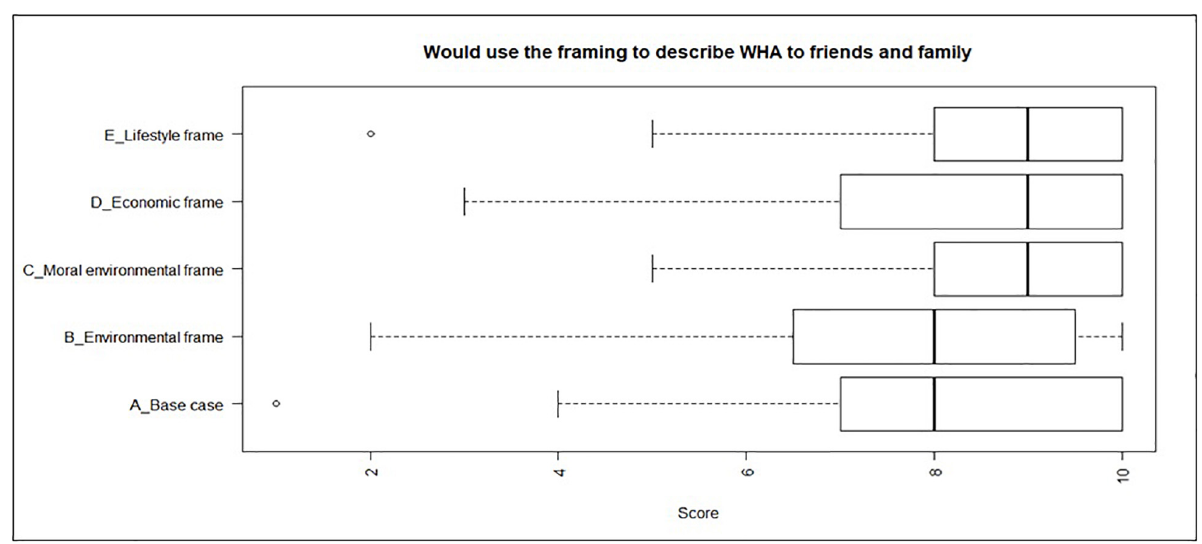
FIGURE 1 | Level of agreement (where 1 is strongly disagree and 10 is strongly agree) by survey respondent ( n = 163) with the different four message frames (i.e., short statements used to describe the Ningaloo Coast WHA that accentuate certain aspect to make the information more persuasive). The four frames